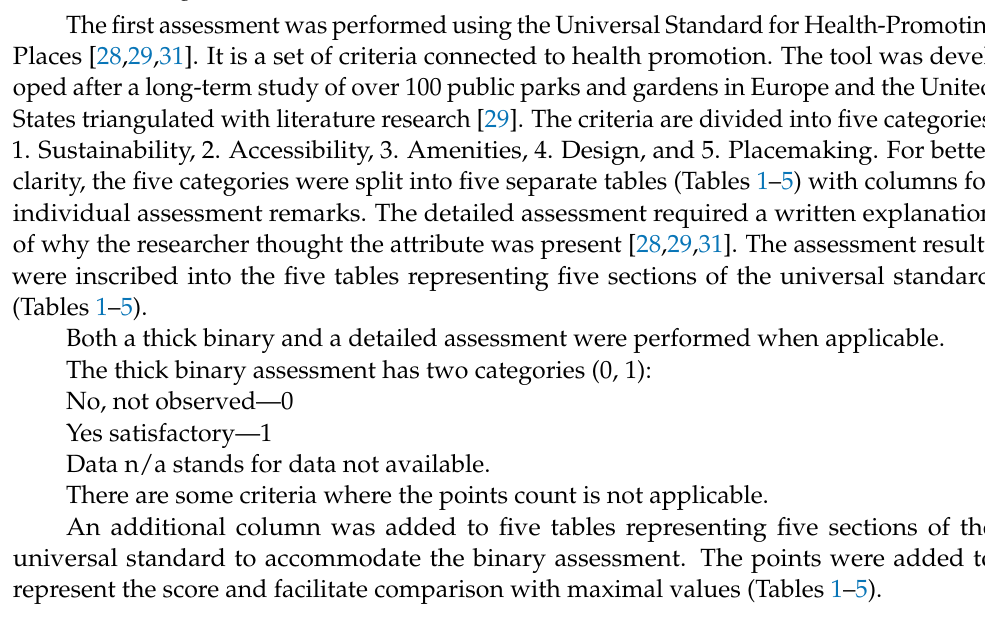
Table 1. Assessment of Public Park in Rumia—part 1, source: